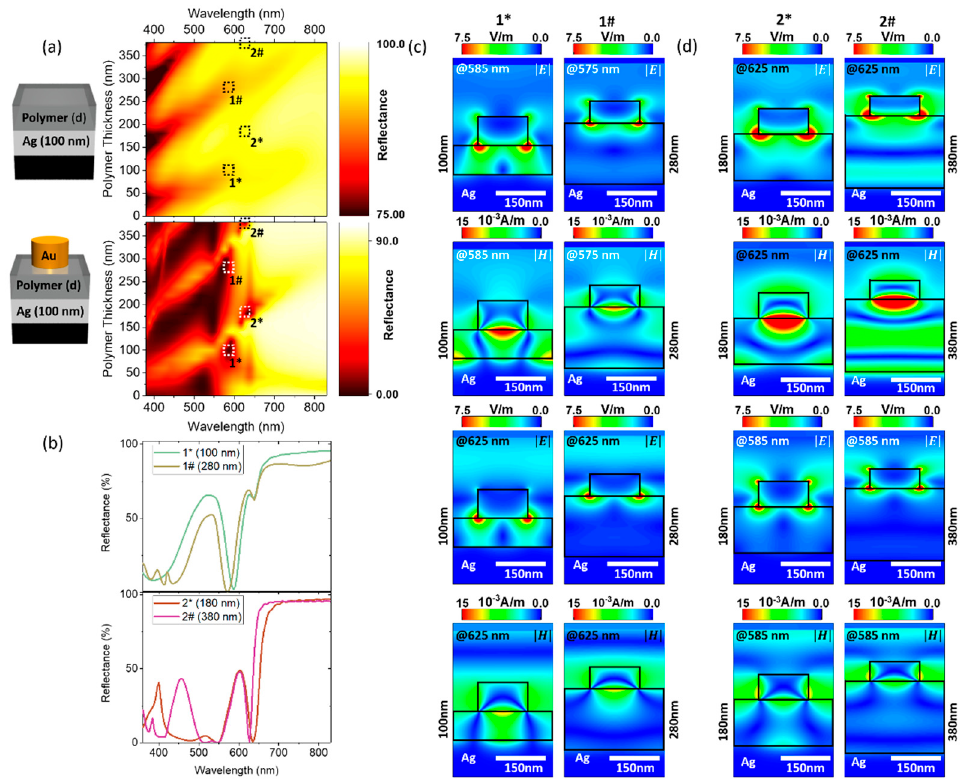
Figure 2. ( a ) Comparison of the reflectance of the back-reflector alone with the reflectance from the Au nanodisc-Ag back-reflector hybrid structure. The occurrence as well as absence of the spectrally narrow features at 585 nm and 625 nm are governed by the interaction of localized plasmonic modes of the nanodiscs with the thin film modes of the back-reflector. ( b ) Simulated reflectance spectra of the hybrid structures for polymer spacer thicknesses of 100 nm (1*), 280 nm (1#), 180 nm (2*) of 380 nm (2#). The spectra are displayed in the individual generated colours (sRGB). ( c ) Electric and magnetic field distributions at 585 nm / 575 nm and at 625 nm along the vertical cross section (x–z plane) through one unit cell of hybrid structures with polymer thicknesses of 100 nm and 280 nm. In our coordinate system, the plane wave excitation is normally incident from the airside of the nanostructure, i.e., k vector parallel to the z-axis, and p–polarized, polarization parallel to the x–axis. The black lines in the field maps indicate the gold nanodiscs, the air-polymer and the polymer silver interfaces. ( d ) Electric and magnetic field distributions at 625 nm and 585 nm along the vertical cross section through one unit cell of hybrid structures with polymer thicknesses of 180 nm and 380 nm.